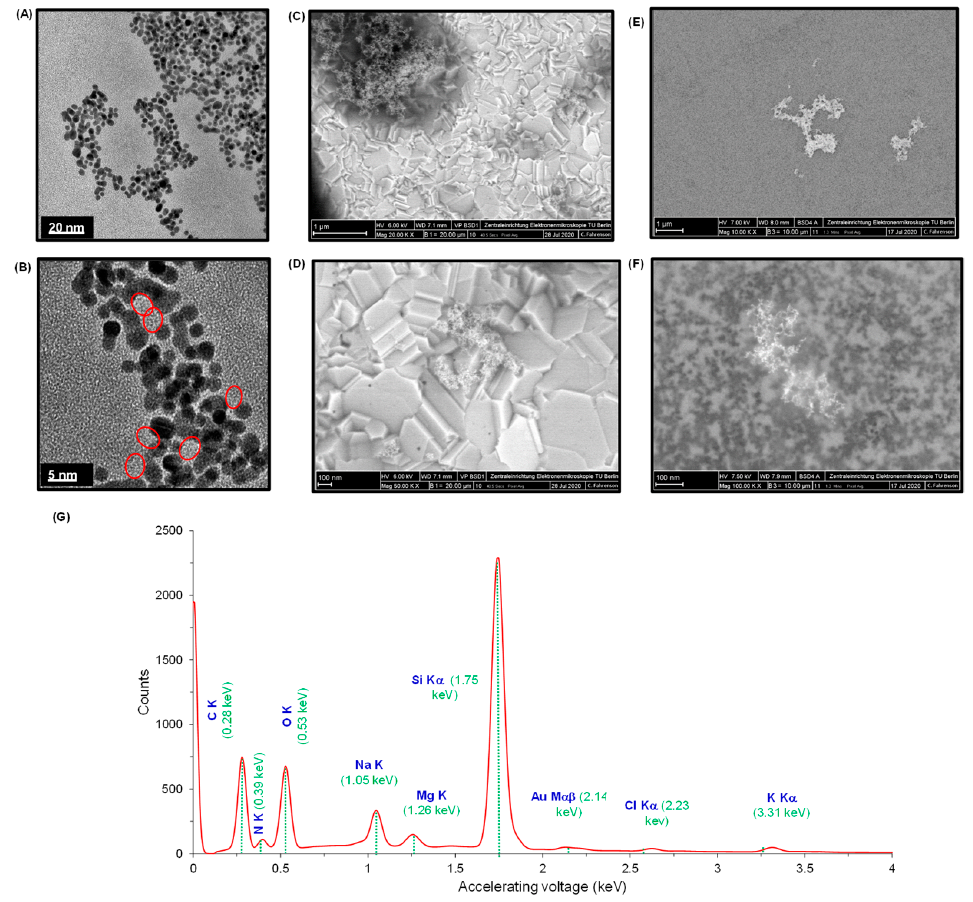
Figure 4. TEM images of AuNPs@GQDs at ( A ) 20 nm and ( B ) 5 nm scales. SEM images of AuNPs@GQDs/SPGE at ( C ) 1 µ m and ( D ) 100 nm scales at 20,000 × and 50,000 × magnifications, respectively. SEM images of GQDs@AuNPs/Si-Wafer at ( E ) 1 µ m and ( F ) 100 nm scales at 10,000 × and 100,000 × magnifications, respectively. ( G ) EDX spectrum of AuNPs@GQDs. The dotted green lines correspond to the accelerating voltage of their respective chemical